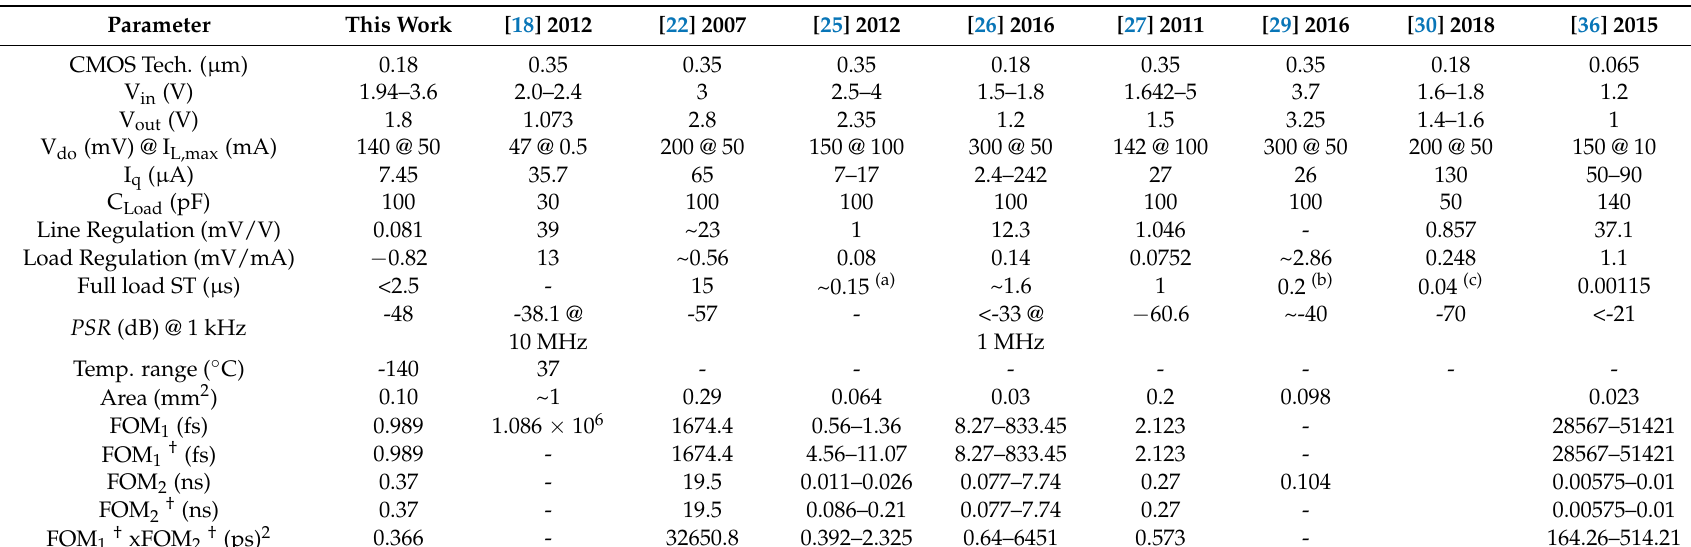
Table 1. Comparison of CMOS Capacitorless LDO